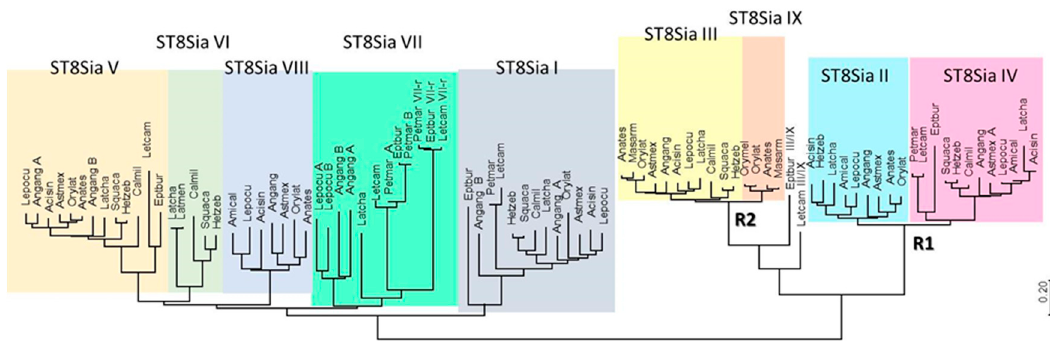
Figure 2. Minimum evolution phylogenetic tree of 89 chordates ST8Sia. The evolutionary history of 89 ST8Sia (see names and sequences in Supplemental Data 1) was inferred using the minimum evolution (ME) method. The optimal tree drawn to scale with the sum of branch length = 16.02931149 is shown. The evolutionary distances were computed using the JTT (Jones-Taylor-Thornton) matrix-based method and the rate variation among sites was modeled with a gamma distribution (shape parameter = 5). The ME tree was searched using the close-neighbor-interchange (CNI) algorithm at a search level of 1. The neighbor-joining algorithm [39] was used to generate the initial tree. The analysis involved 89 amino acid sequences and all positions with less than 95% site coverage were eliminated. A total of 226 positions were in the final dataset (see multiple sequence alignments in Supplemental Data 2). Evolutionary analyses were conducted in MEGA7.0 [40]. The nine Vertebrate subfamilies of ST8Sia (ST8Sia I to ST8Sia IX) are indicated by various colors.